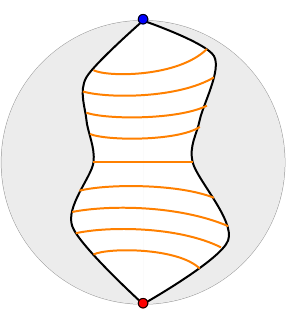
Figure 10. The shape of the two branes are fluctuating. The orange curves are representatives of the bulk minimal area surfaces. The orange curve are of different length and we pick up the shortest one of them to calculate the entanglement entropy between the two defects (the blue dot and the red